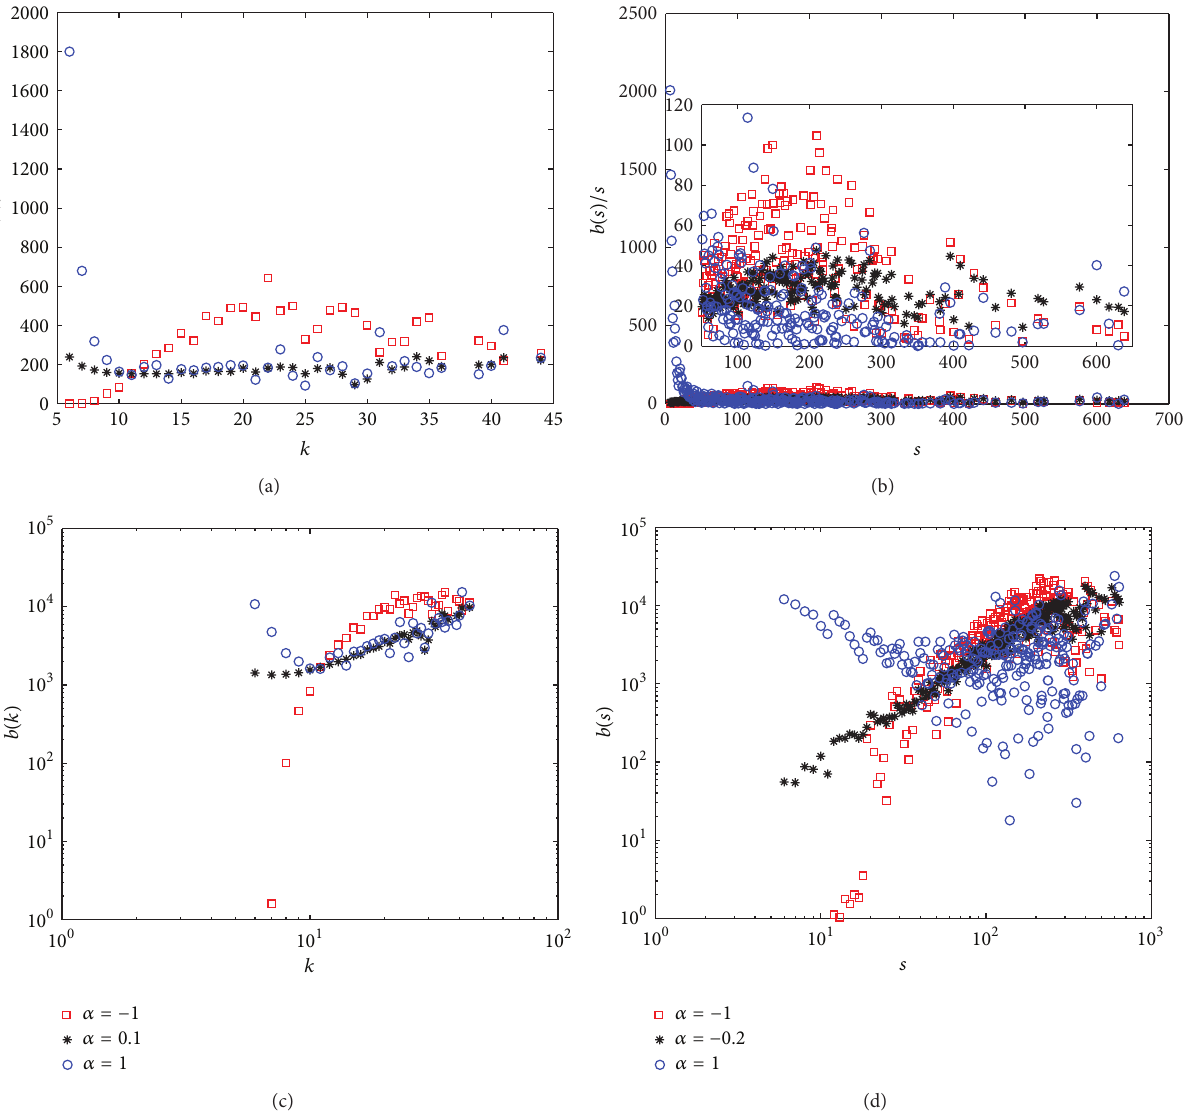
Figure 5: BBV network with 𝑛 = 1000 , 𝛿 = 6 , 𝑚 = 6 , and 𝜔 0 = 1 . (a) DEGC, betweenness per node. (b) STRC, betweenness per node. (c) DEGC, betweenness distribution versus node degree. (d) STRC, betweenness distribution versus node